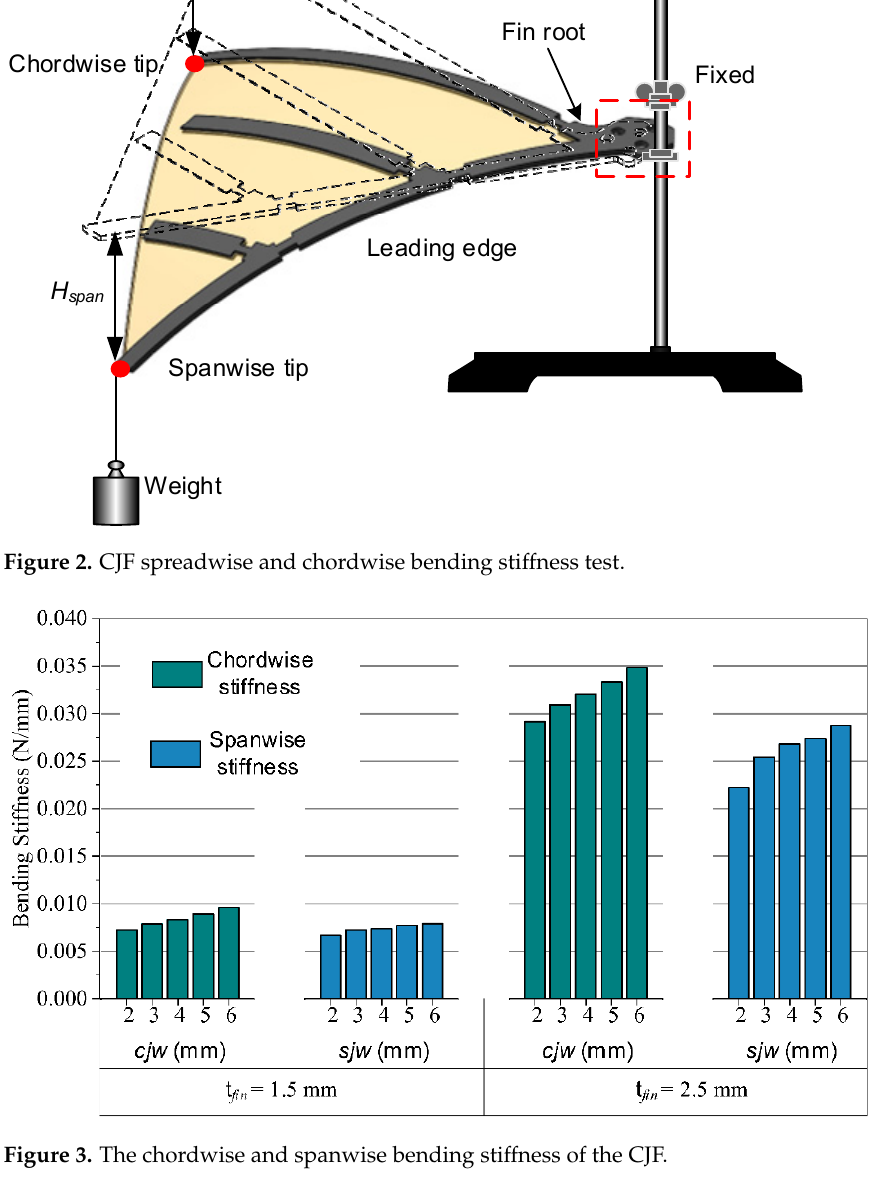
Figure 3. The chordwise and spanwise bending stiffness of the CJF.